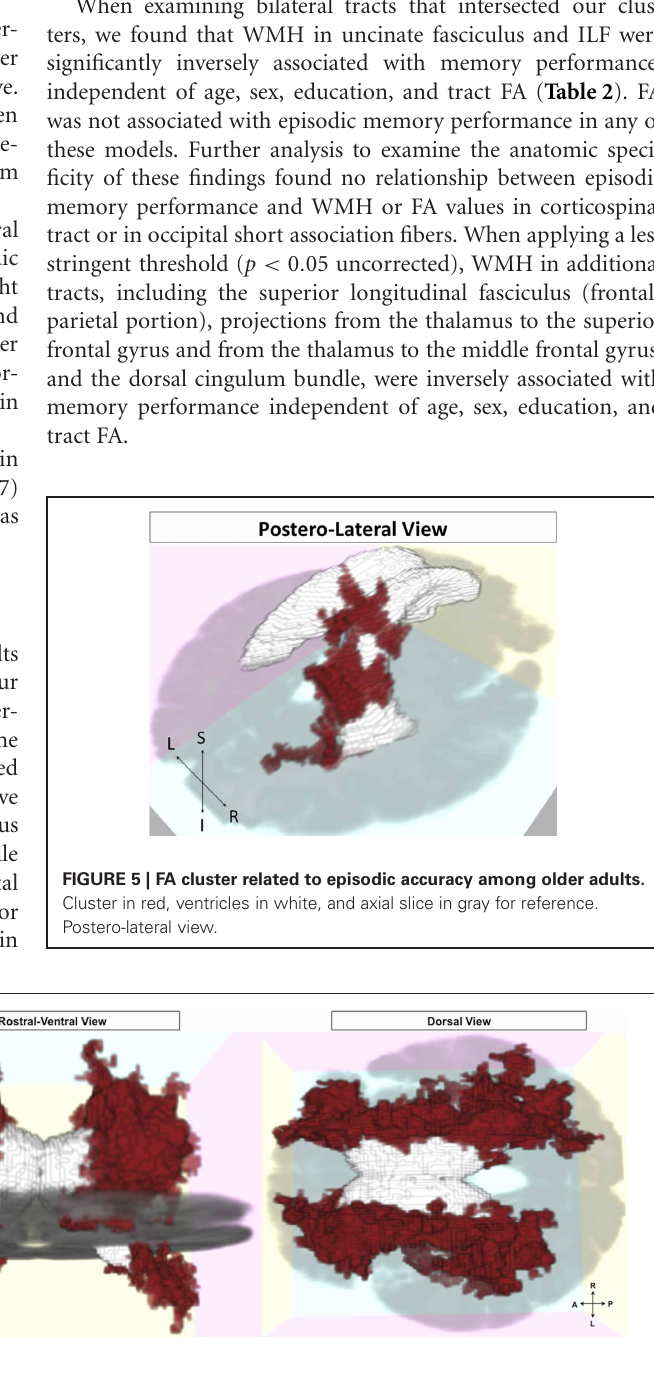
slice in gray for reference. Left: rostral-dorsal view; Middle: rostral-ventral view; Right: dorsal view (all images radiological